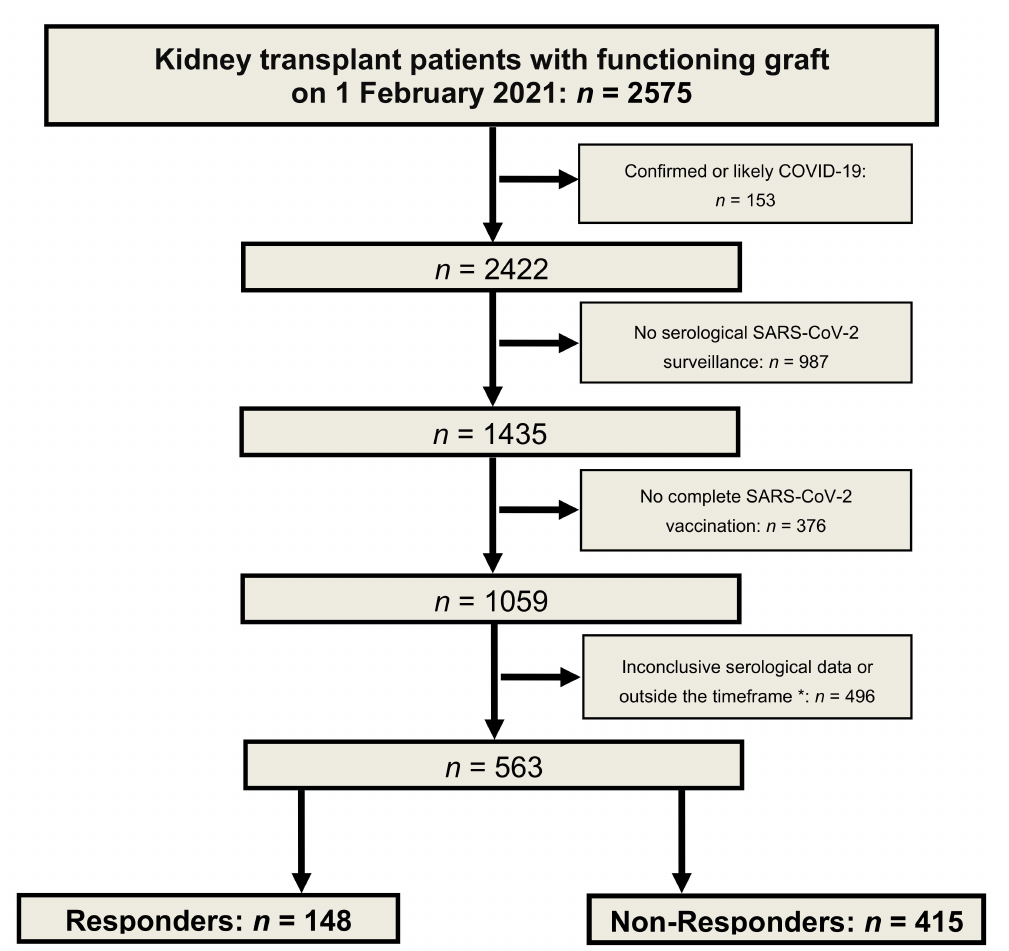
Figure 1. Algorithm for the definition of a cohort of responders and non-responders after standard